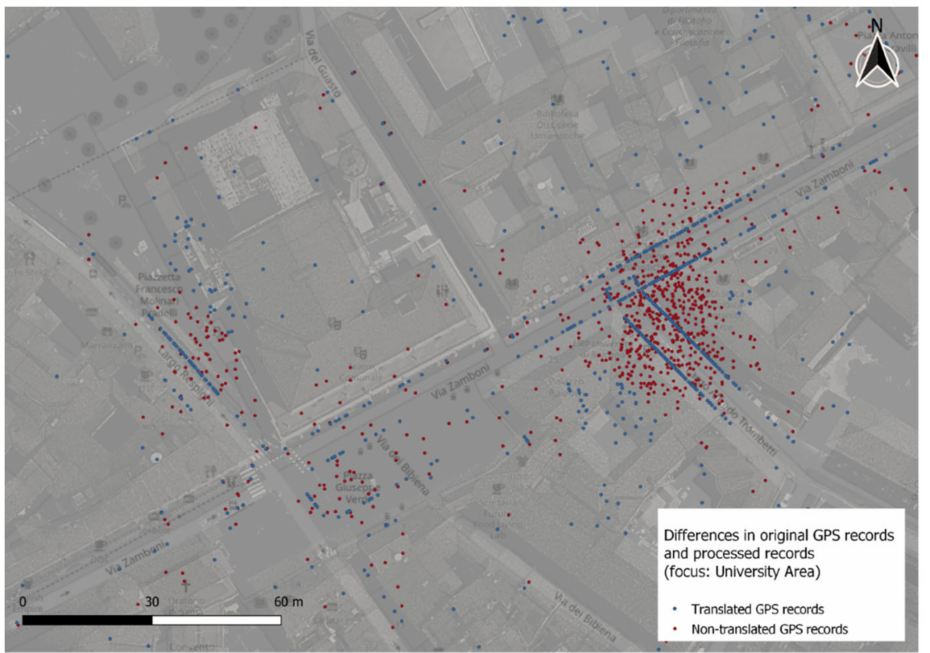
Figure 3. Differences in original GPS records and processed